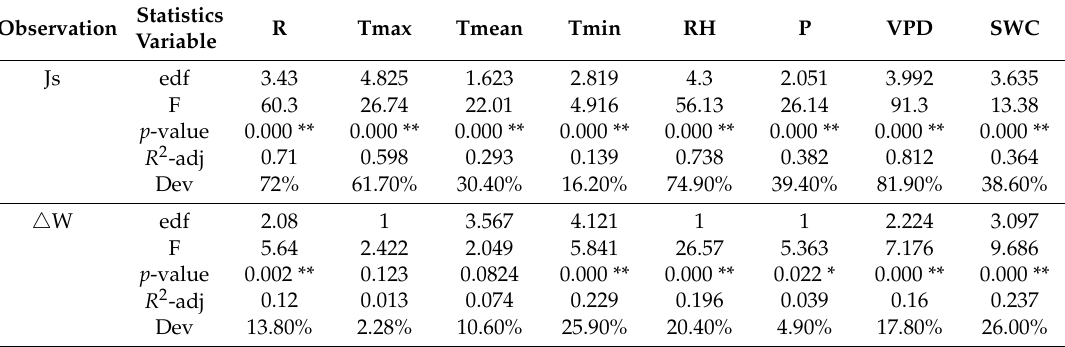
Table 2. GAM results of tests for the relationships between Js and (cid:52) W, and single environmental variables.